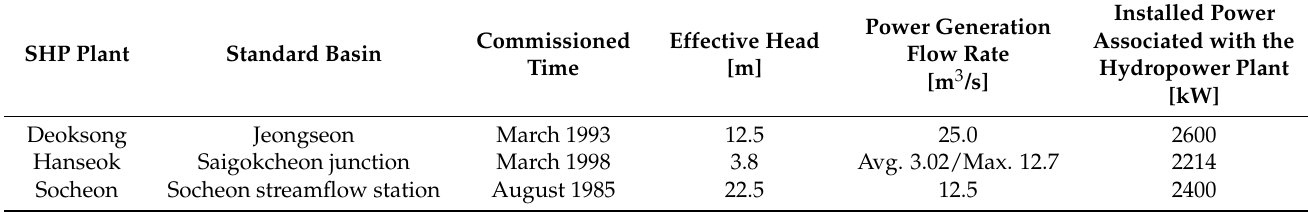
Table 1. Information on SHP plants of target basins (reprinted from [8]).